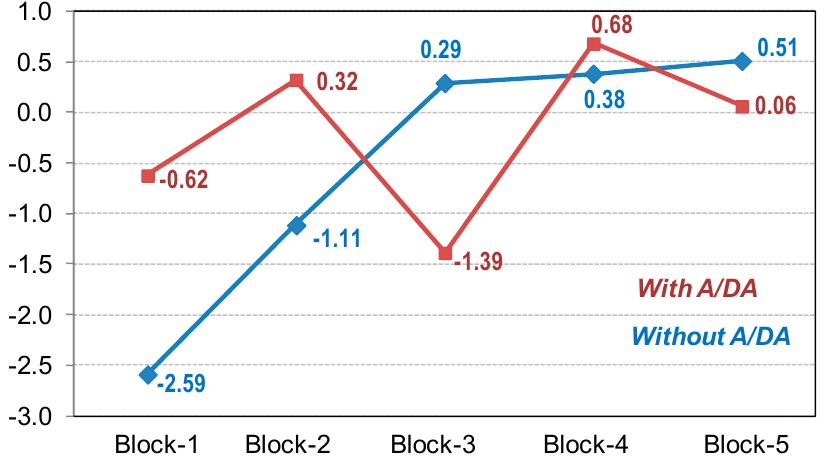
Figure 1. Learning curve in the IGT measure. Note. A/DA: alcohol and/or drug abuse. Sample size: n = 145.